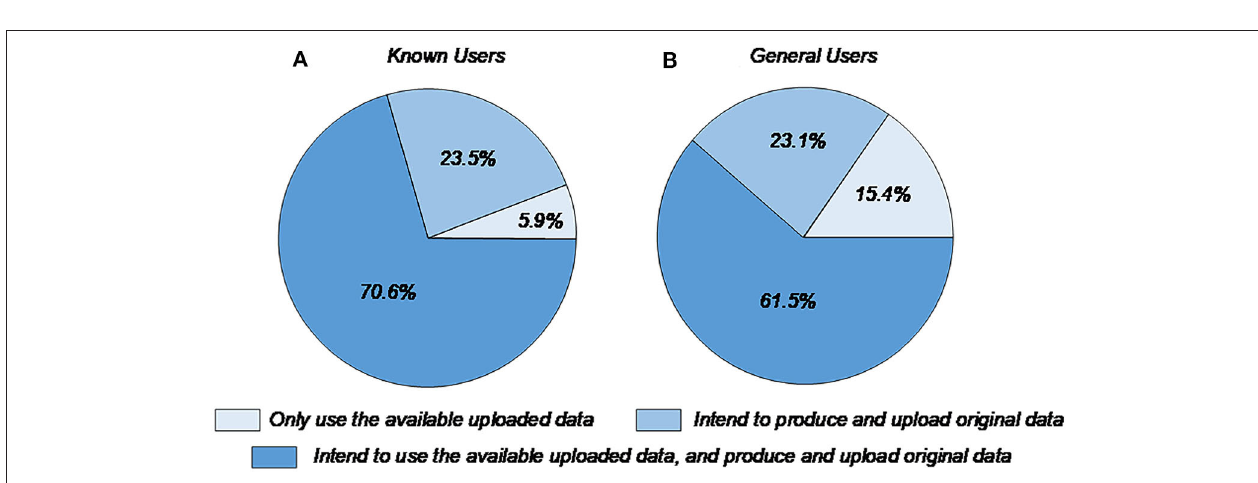
FIGURE 5 | Intended use of online NHERI resources by user group. (A) is the known users, and (B) is the general users.